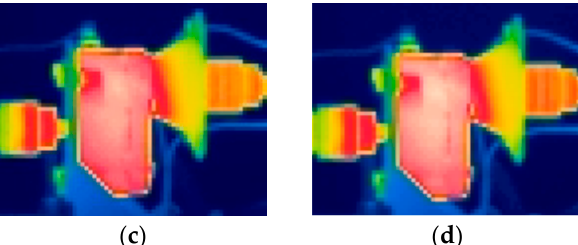
Figure 5. Acquired signals for the condition monitoring of gears in a gearbox transmission system with infrared thermography: ( a ) HTL gears, and ( b ) 25%, ( c ) 50%, and ( d ) 75% uniform wear in the gears.